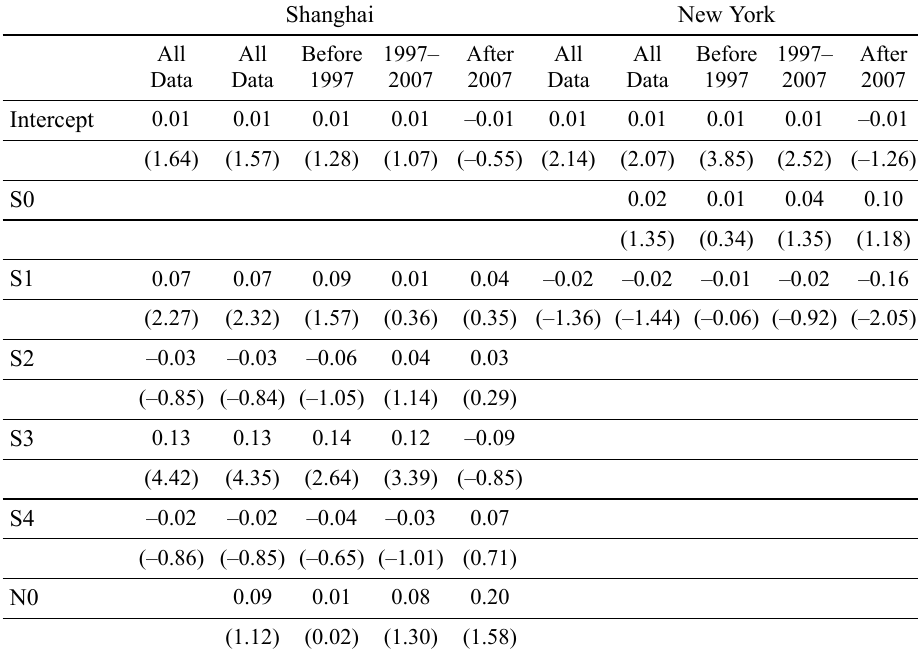
Table 9. Regressions of volatility of Shanghai and New York stock prices The table presents the regressions of the volatility of return of Shanghai and New York stock prices in total sample and three subsamples: before 1997, after 1997 and before 2007, and after 2007. The rate of return is calculated as the change in the natural logarithm of the price index in a given period. The volatility of returns is calculated as the absolute value of the change in the natural logarithm of the price index in a given period. The price index is obtained from DataStream Equity Indices. S0 represents the raw rate of return of Shanghai stock prices while N0 represents the raw rate of return of New York stock prices. S1 (S2, S3, S4) represents the one-lagged (two-lagged, three-lagged, four-lagged) of the rate of return of Shanghai stock prices while N1 (N2, N3, N4, N5) represents the one lagged (two-lagged, three-lagged, four-lagged, five-lagged) of the rate of return of New York stock prices. We also report R-squared and Root MSE. T -statistics are provided in the parentheses. The sample period is from January 1991